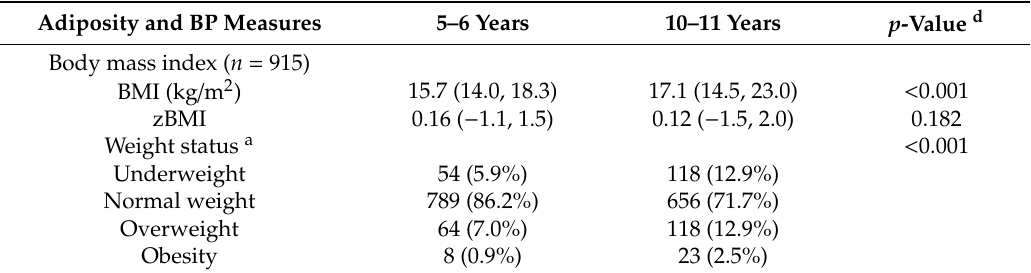
Table 2. Adiposity and blood pressure measurements of the